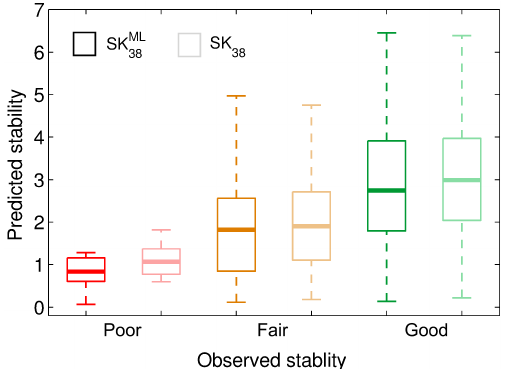
Figure 7. SK ML (left) vs. SK 38 (right) predicted stability distri- 38 butions per observed stability class (poor: manual profiles with RB scores 1 and 2, N poor = 10; fair: manual profiles with RB scores 3 and 4, N fair = 53; good: manual profiles with RB scores 5, 6 and 7, N good = 97). Boxes span the interquartile range from 1st to 3rd quartile with a horizontal line showing the median. Whiskers show the range of observed values that fall within 1.5 times the in- terquartile range above and below the interquartile range.